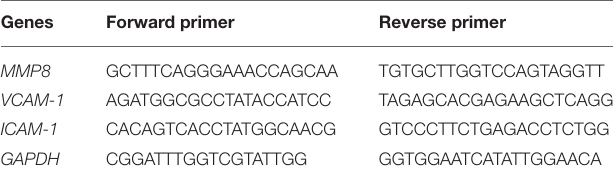
TABLE 1 | Sequence of primers for Real-Time